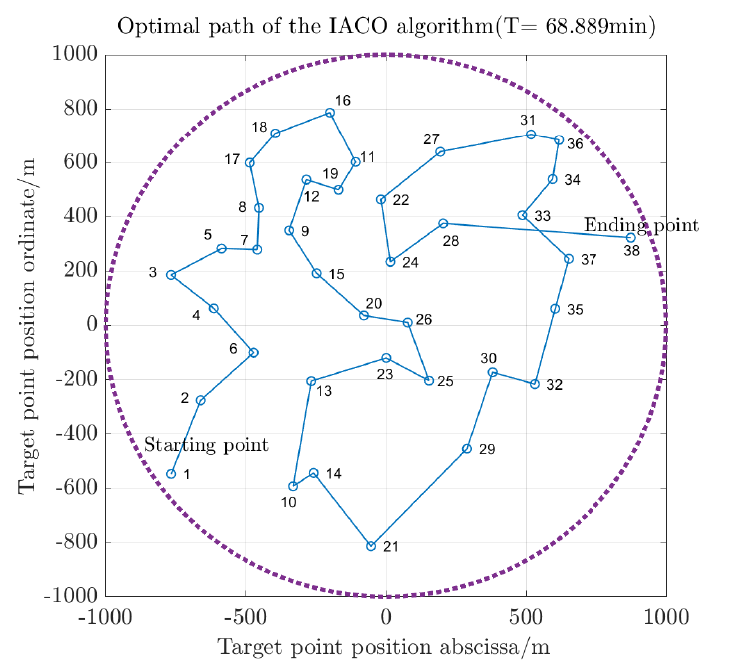
Figure 7. Optimal path created by the IACO